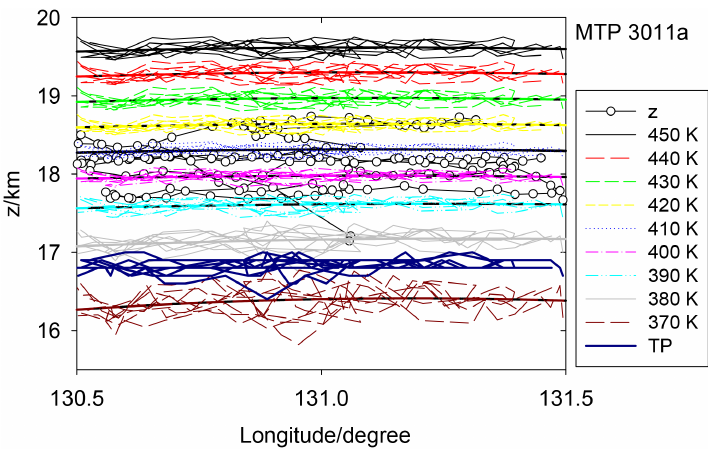
Figure 15. Tropopause (TP) and isentrope altitudes for potential temperature between 370 and 450K, from MTP versus longitude (with thick parabolic regression curves), including the stratospheric flight part over Hector, 18000s< t <25200s, 130.5 ◦ <longitude<131.5 ◦ E, 30 November 2005. The parabolas indicate lifting over Hector by ∼ 100m at 370K and 50m at 450K. The black line with open circles depicts the Geophysica flight altitude above